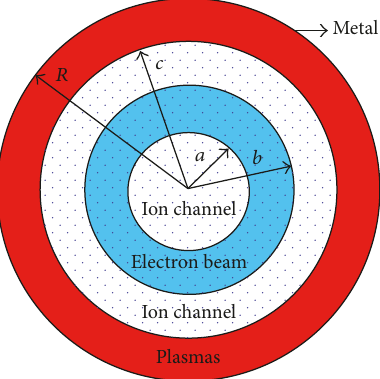
Figure 1: The cross section of the annular beam-ion channel system. The annular electron beam with inner radius 𝑎 and outer radius 𝑏 , ion channel with radius 𝑐 , and metallic waveguide with radius 𝑅